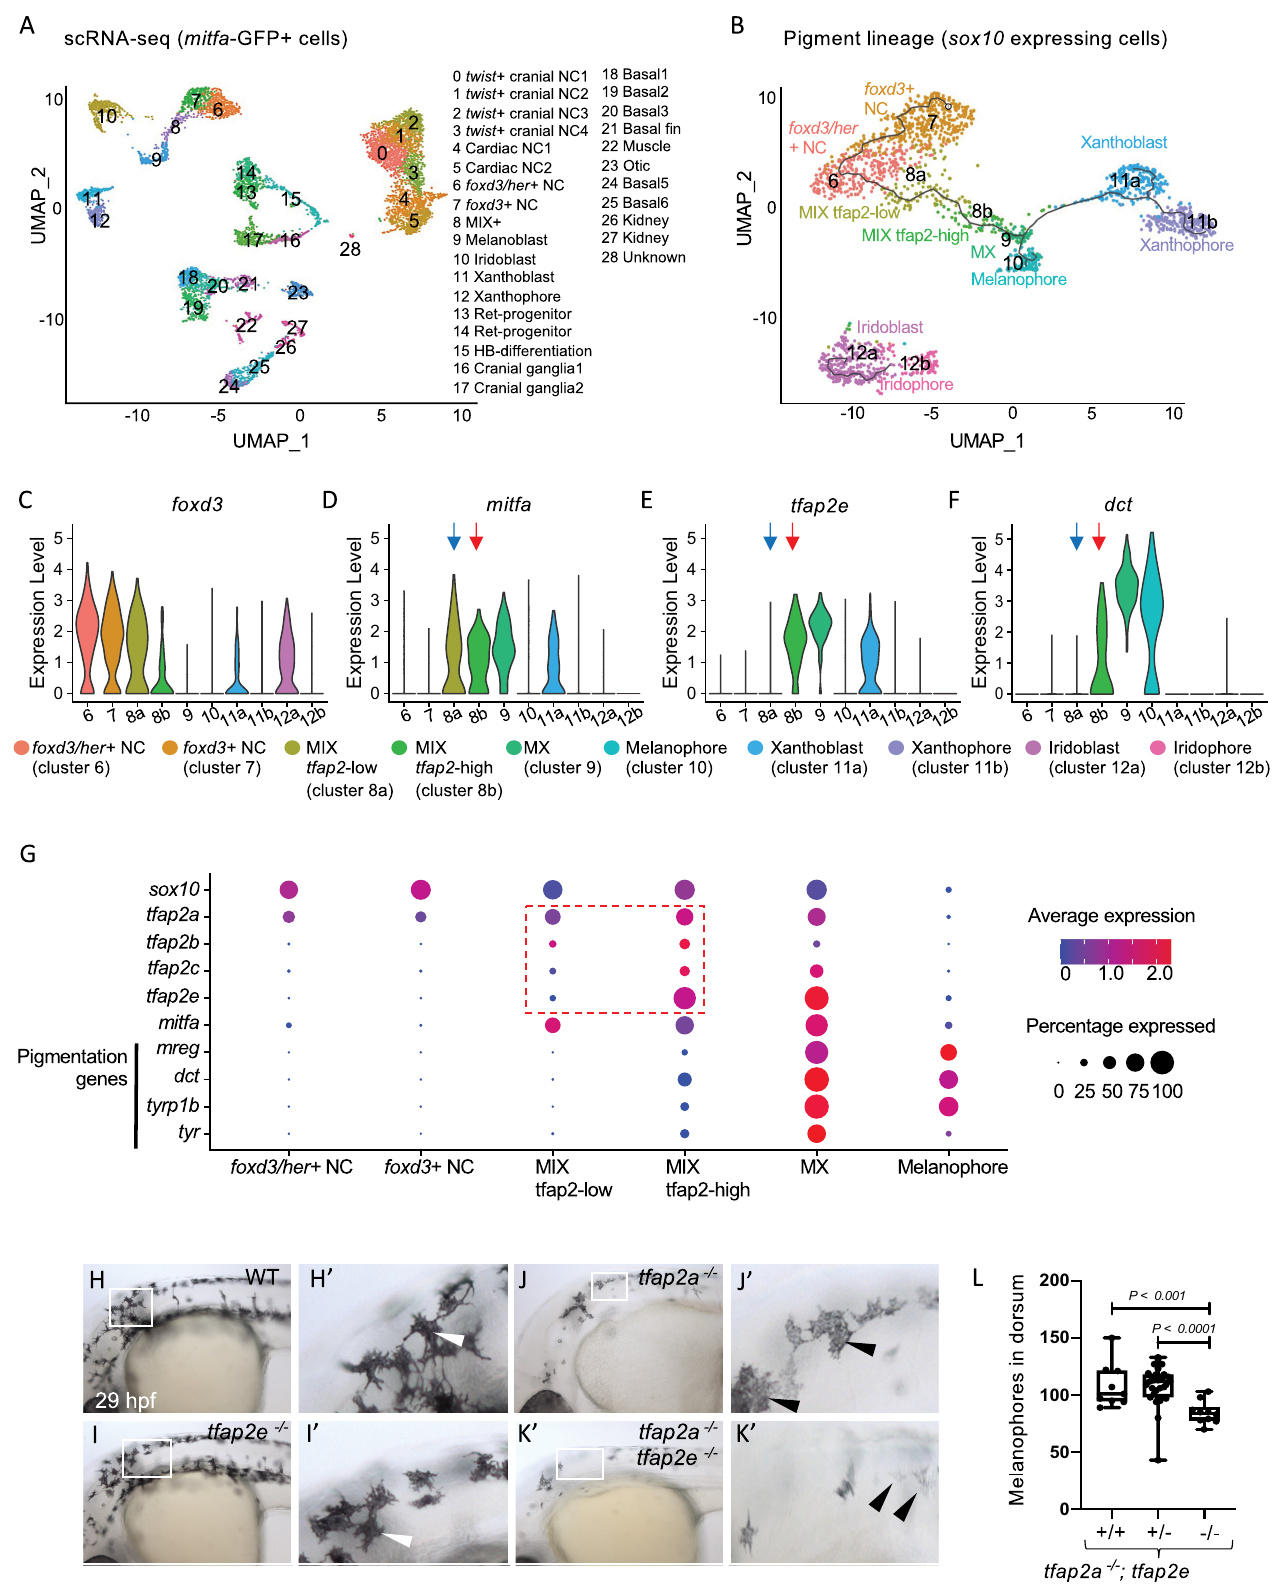
Fig 1. Expression of tfap2 paralogs in the melanophore lineage precedes activation of Mitfa-target genes in-vivo . ( A ) Uniform Manifold Approximation and Projection (UMAP) obtained after clustering (dimensions, dims = 30, resolution = 1.2) GFP+ cells (n = 11,217 cells) sorted from Tg(mitfa : GFP)